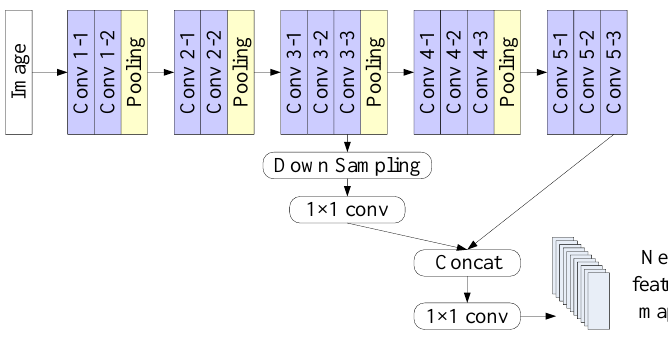
Figure 2. Feature fusion in the proposed architecture.